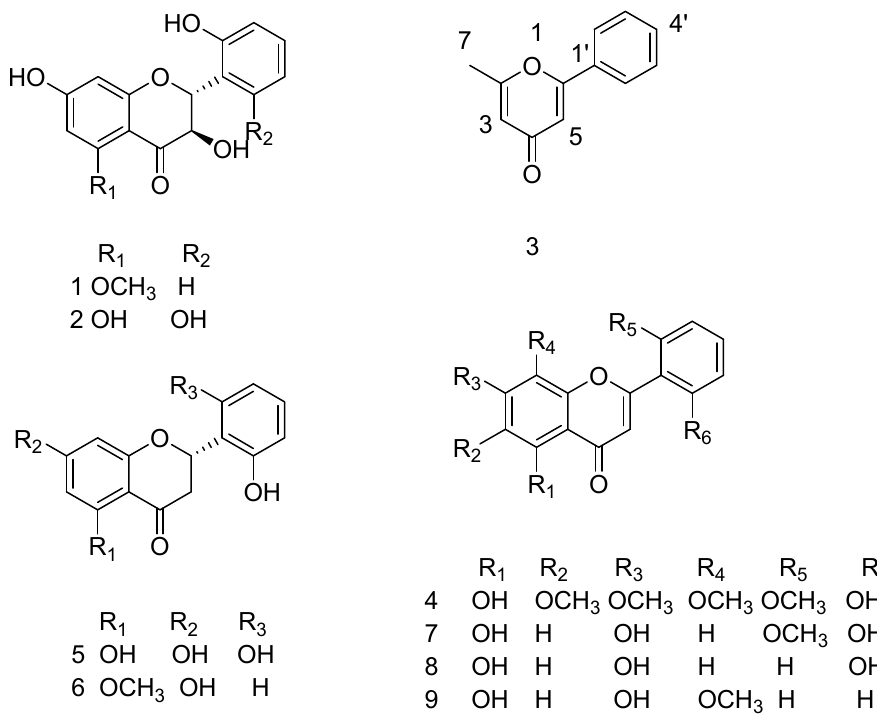
Figure 2. Chemical structures isolated from S. baicalensis.